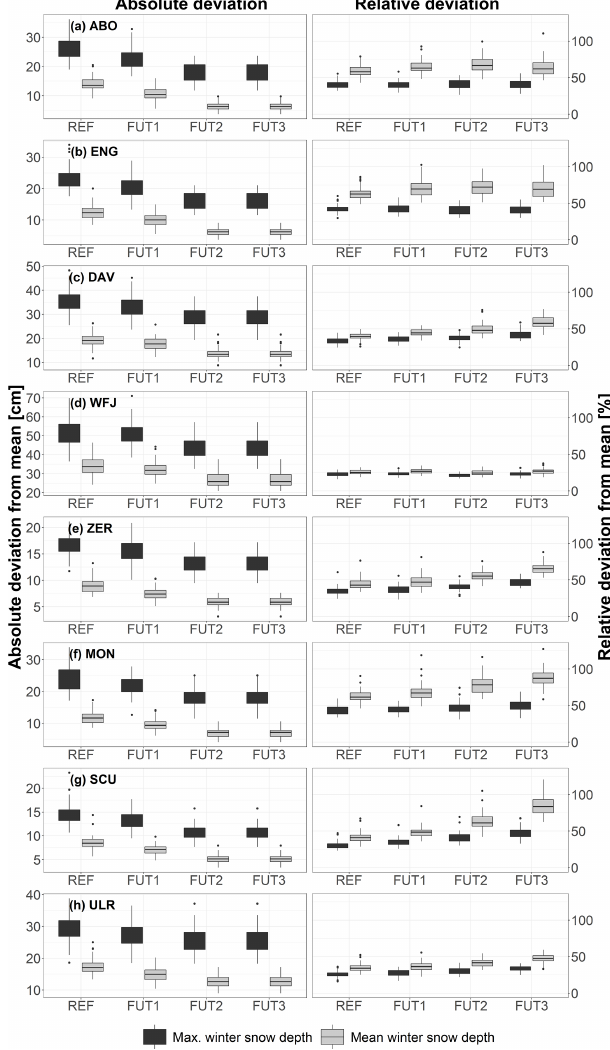
Figure 9. Interannual variability for the REF (1980 to 2009), FUT1 (2010 to 2039), FUT2 (2040 to 2069) and FUT3 (2070 to 2099) pe- riods expressed as the absolute standard deviation (cm; left) and standard deviation relative to the mean (%; right) for mean and maximum snow depth for the stations Adelboden (ABO), Engel- berg (ENG), Davos (DAV), Weissfluhjoch (WFJ), Zermatt (ZER), Montana (MON), Scuol (SCU) and Ulrichen (ULR). The boxes rep- resent the interquartile range with the median as a horizontal line. The whiskers represent 1.5 times the interquartile range, and the dots represent